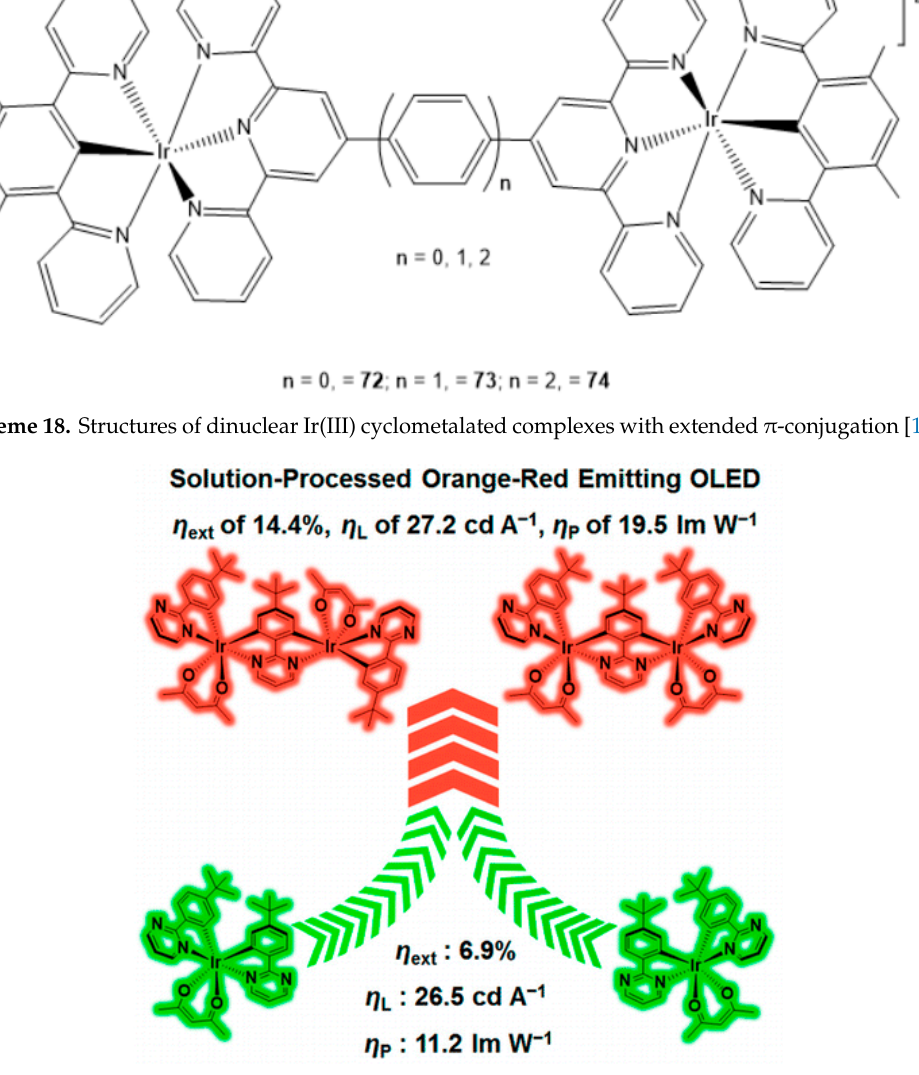
Figure 8. Emission profiles of mono- and dinuclear iridium(III) complexes with phenylpyrimidine derivative [105]. [Adapted with permission from (Yang et al.). Copyright (2016) American Chemical Society].